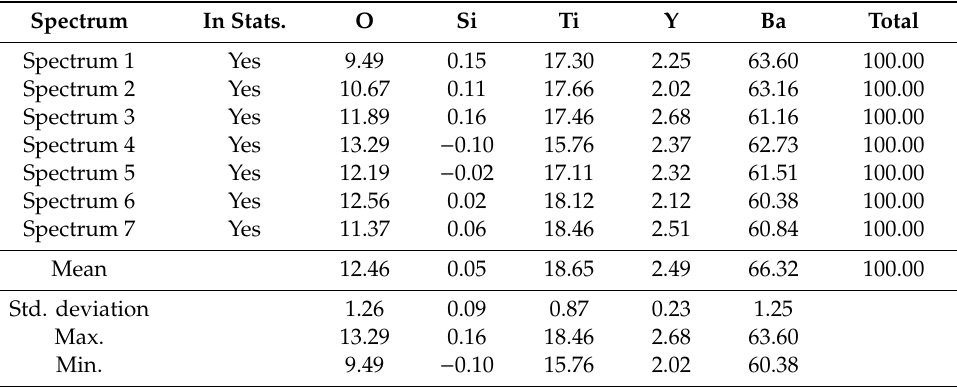
Table 2. EDX analysis of di ff erent points in BT02-MOD-Y (wt%). Spectrum In